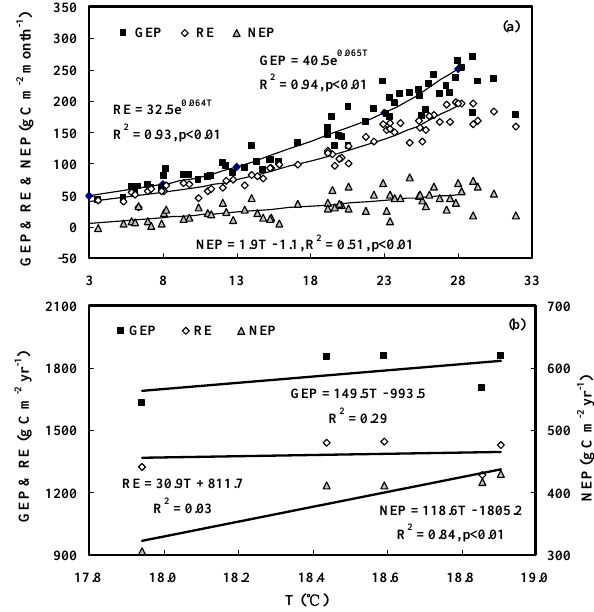
Fig. 4. Response of (a) monthly and (b) yearly gross ecosystem photosynthesis (GEP), ecosystem respiration (RE) and net ecosys- tem production (NEP) to air temperature ( T ) during 2003 to 2007 at Qianyanzhou